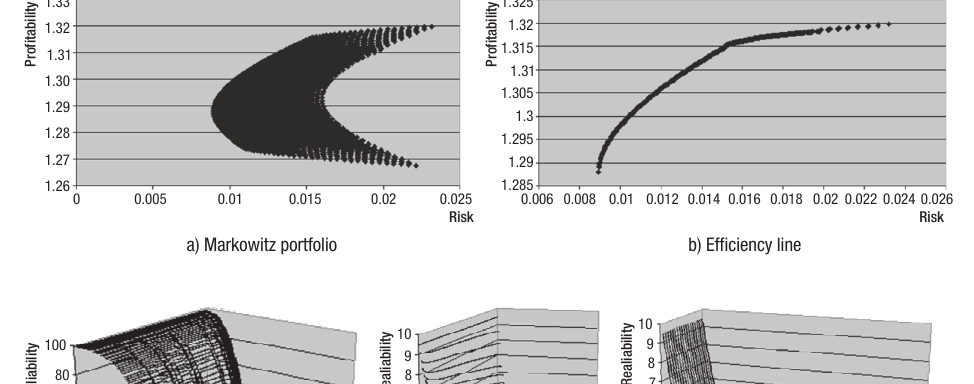
Fig. 7. Visualization of (4)–(6) problem solving, when initial distribution among P is not balanced in equal parts, but according to proportion – and P 4